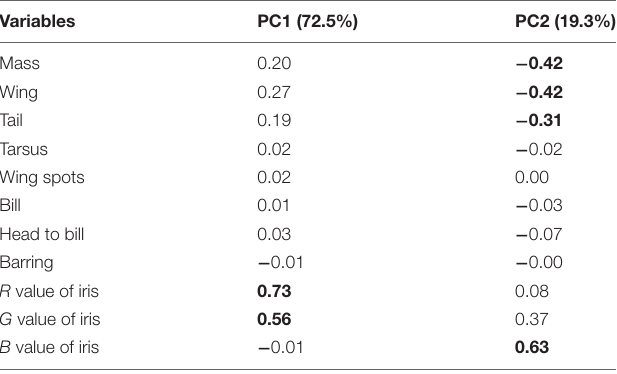
TABLE 4 | Results of the principal component analysis for the 11 morphological traits of the four Cuculus cuckoos.